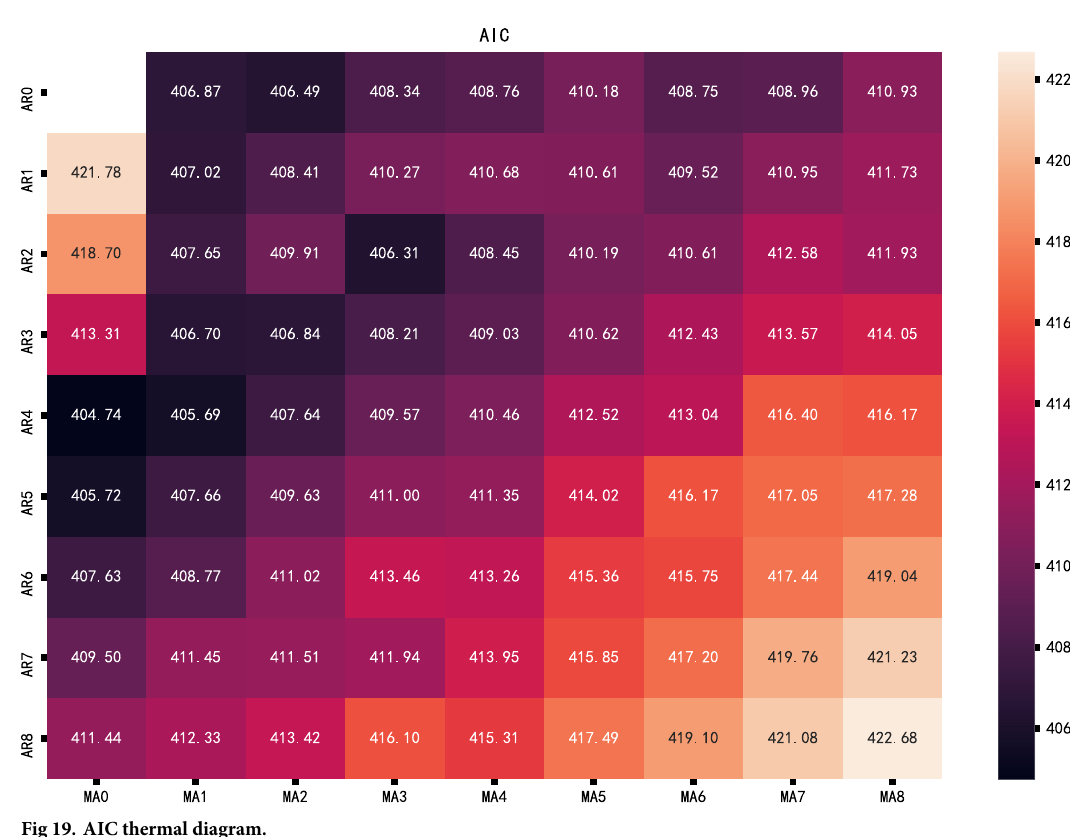
Fig 19. AIC thermal